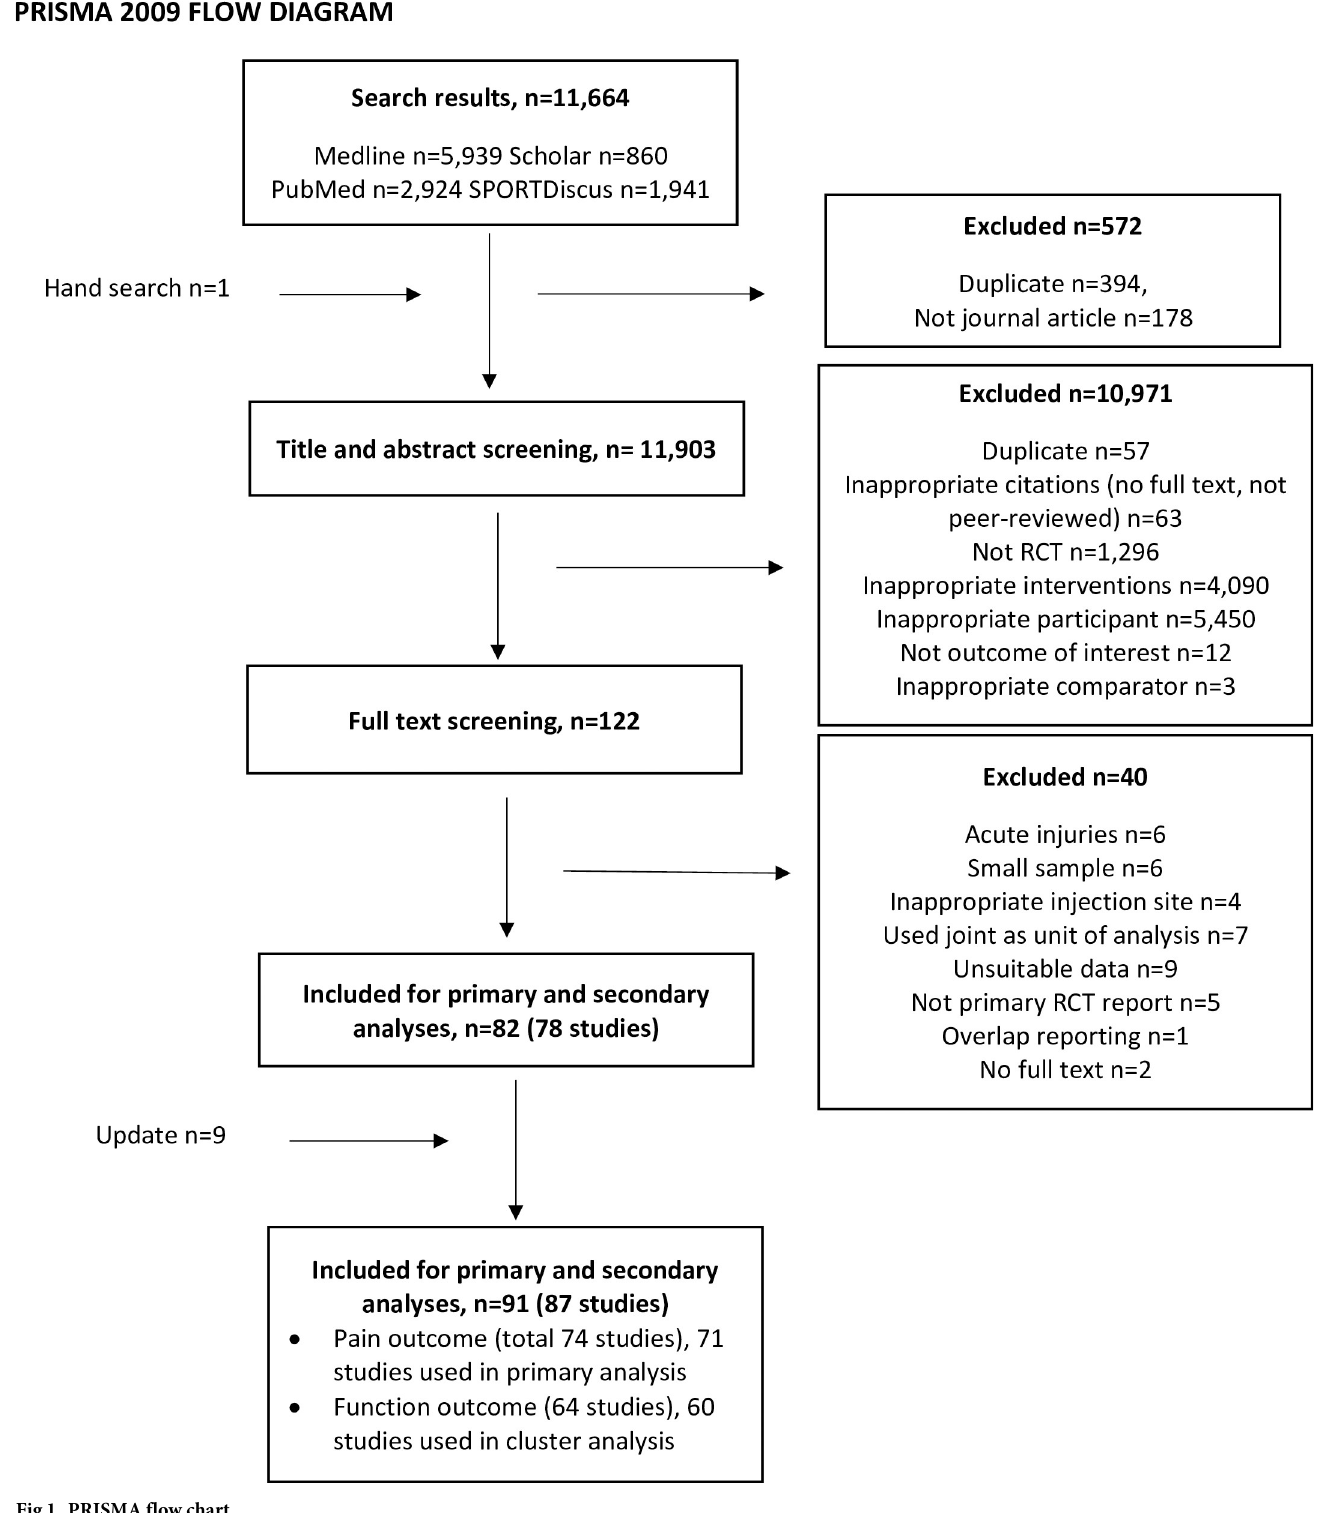
Fig 1. PRISMA flow chart.